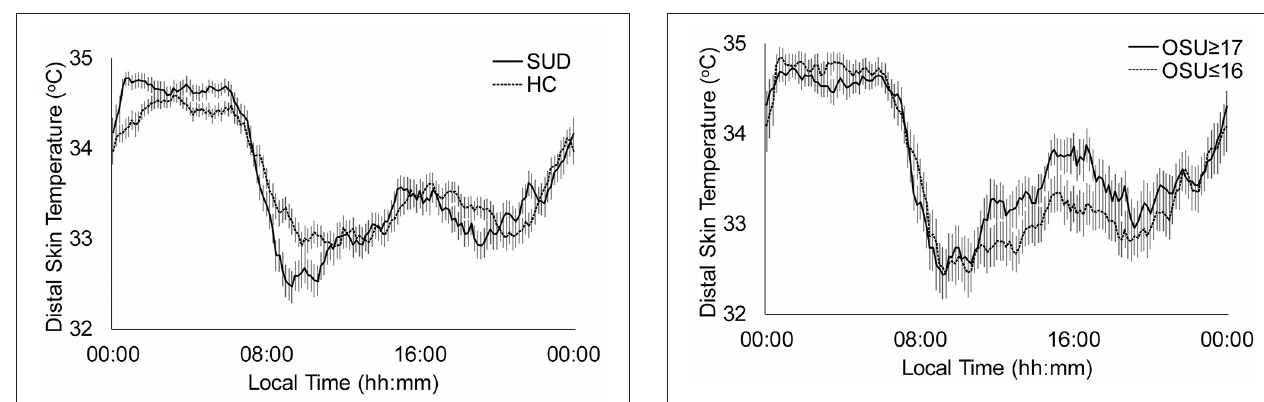
the administration of exogenous melatonin, or light-therapy